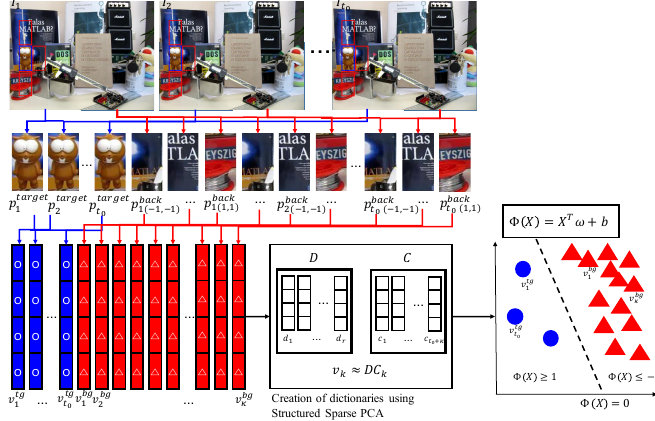
Figure 1. Representation of the target object using structured sparse PCA and deterministic classification between the target object and background image